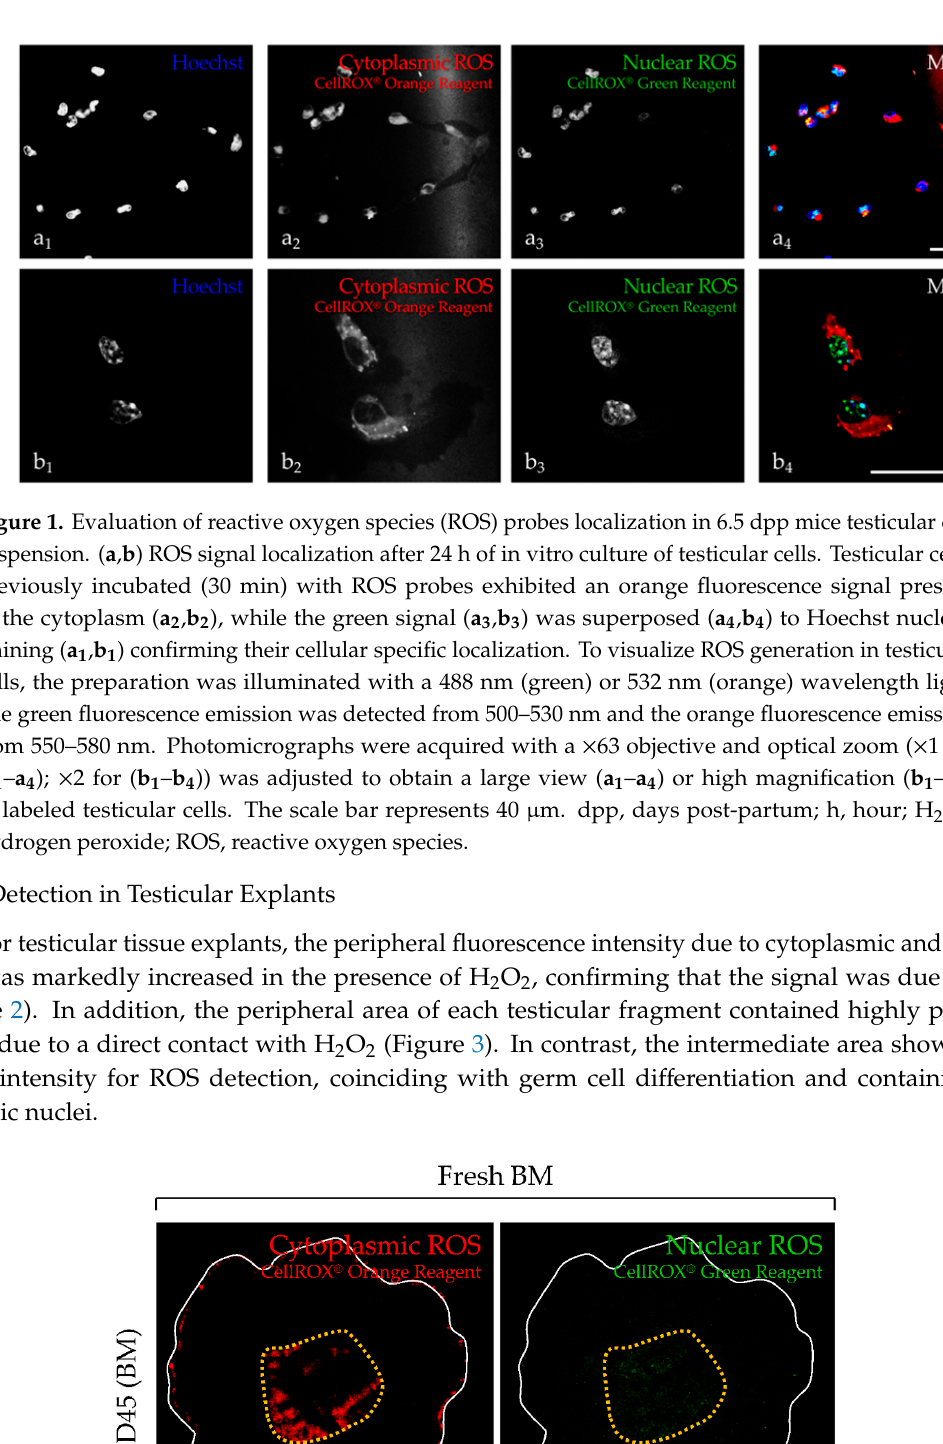
Figure 2. ROS detection in frozen-thawed and living testicular explants using the CellROX kit probes at D45 of culture using ex vivo imaging by confocal macroscopy. To control the specificity of the signal, frozen-thawed (F-T) testicular explants were cultured with basal medium (BM) ( a,a’ ) or incubated with BM supplemented with 200 µM H 2 O 2 ( b,b’ ) overnight as positive controls. Fluorescent signal intensity appeared stronger with H 2 O 2 , either for CellROX orange reagent or green reagent, when compared with BM control. The solid line delineates the outline of the testicular fragment. Necrotic central area is delimited with yellow dotted circle and was not taken into consideration in the peripheral ROS-positive thickness region evaluation (dotted blue line). Photomicrographs were captured with a 1.1 optical zoom at a ×4.9 total magnification. The scale bar